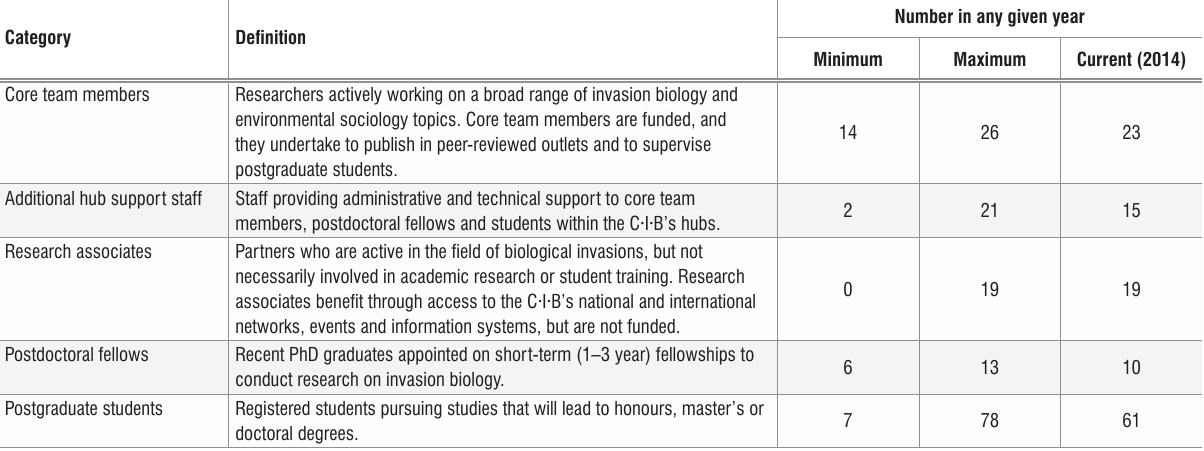
The numbers of different categories of team members of the Centre for Invasion Biology between 2004 and 2014